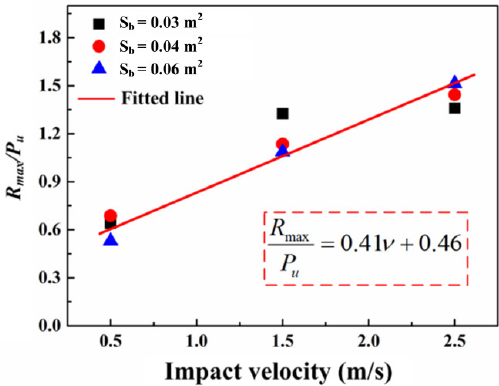
pact energy, the steel bars with a small radius reach the plastic stage easily, which leads